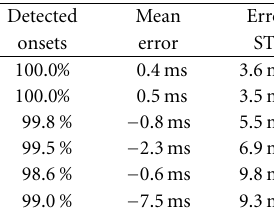
Table 3: Statistics for real SEMG data